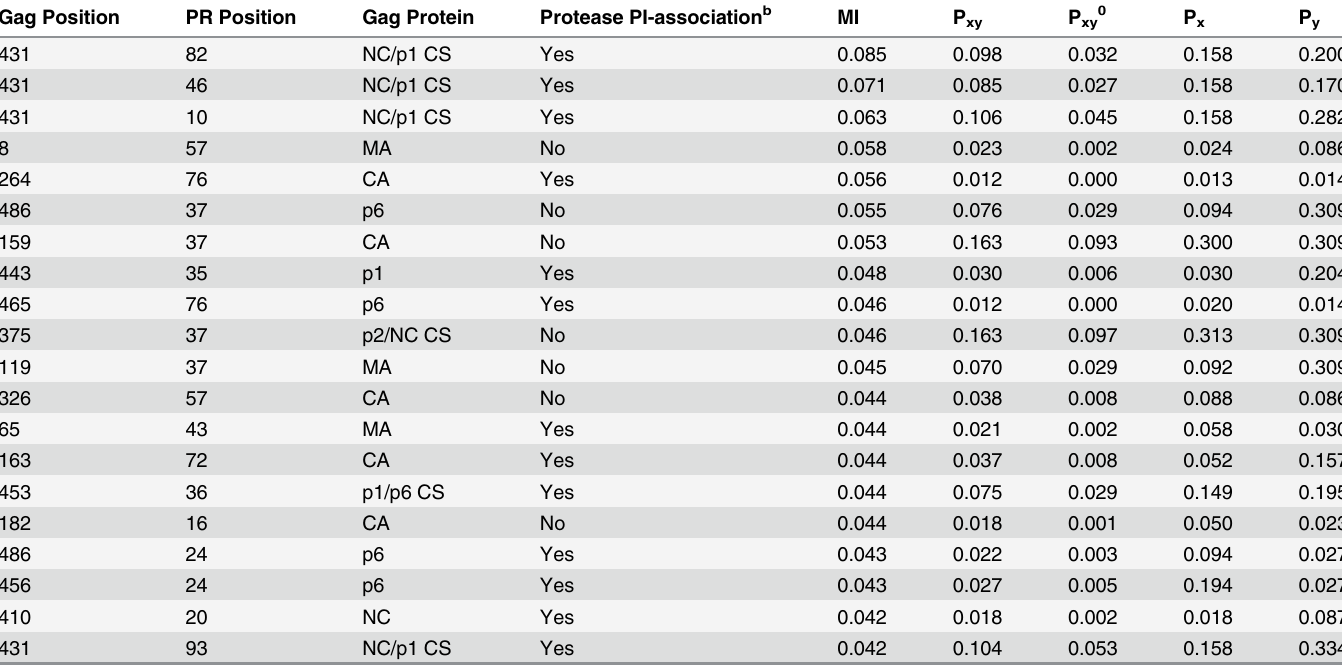
Table 3. Top 20 most strongly correlated pairs of Gag-PR